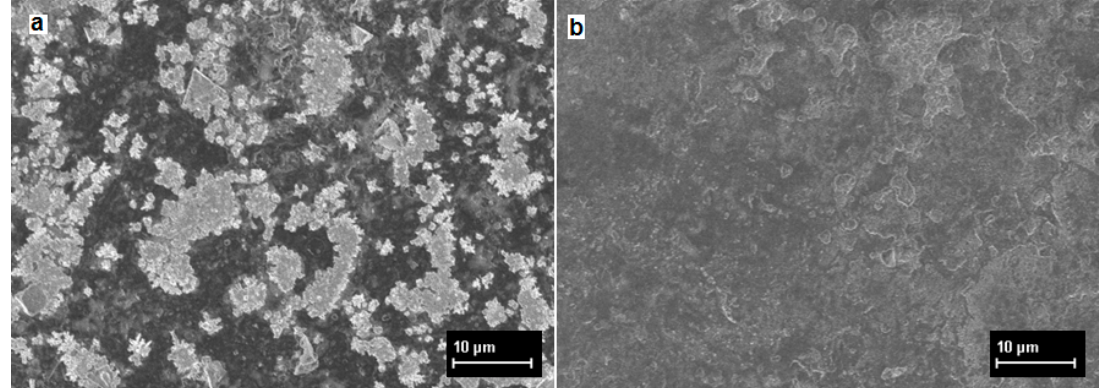
Figure 4. Field emission scanning electron microscope (FESEM) micrographs of copper dipped in ( a ) 1 M HCl and ( b ) 1 M HCl with 1000 ppm of inhibitor.